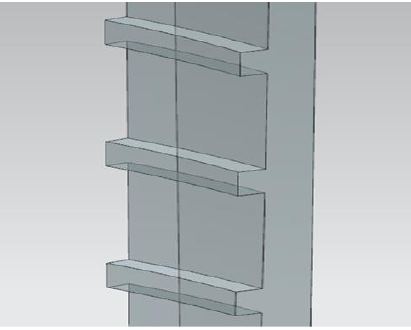
Figure 19. Schematic diagram of the cooling structure of the spoiler rib.